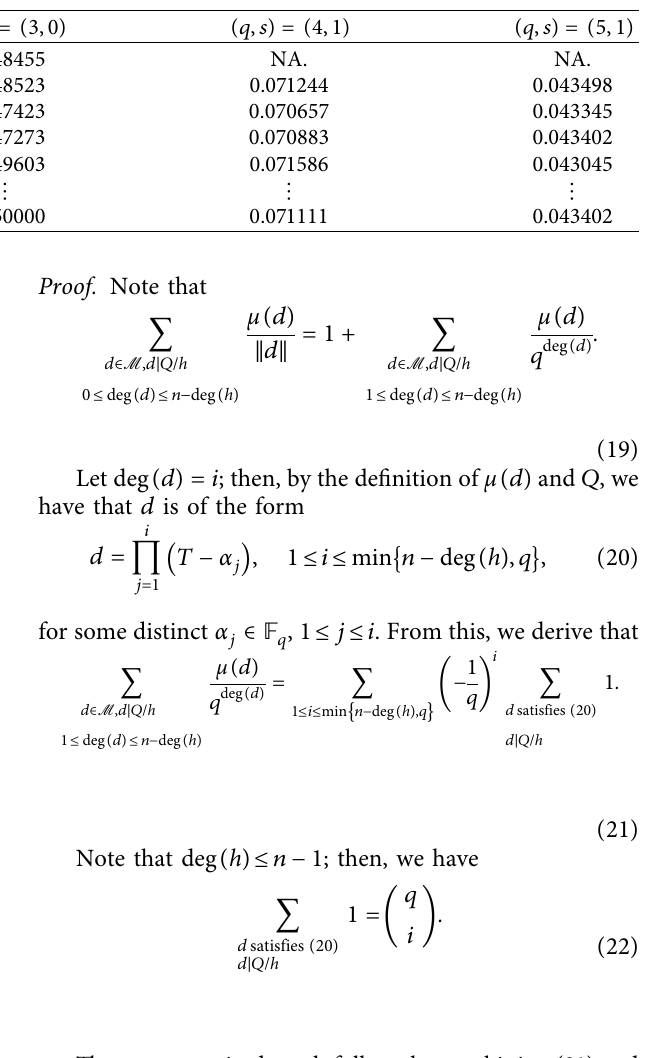
Table 2: Numerical results for the variance V ( T ( n,q )